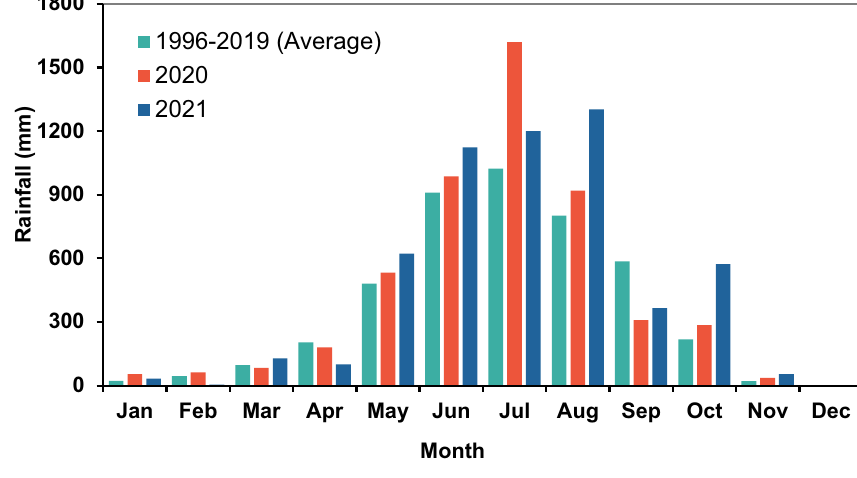
Fig. 2 The aerial view of the geohazard-prone area, a Part of upstream of the study area, b Extended new township development area Fig. 3 Phuentsholing monthly rainfall record from